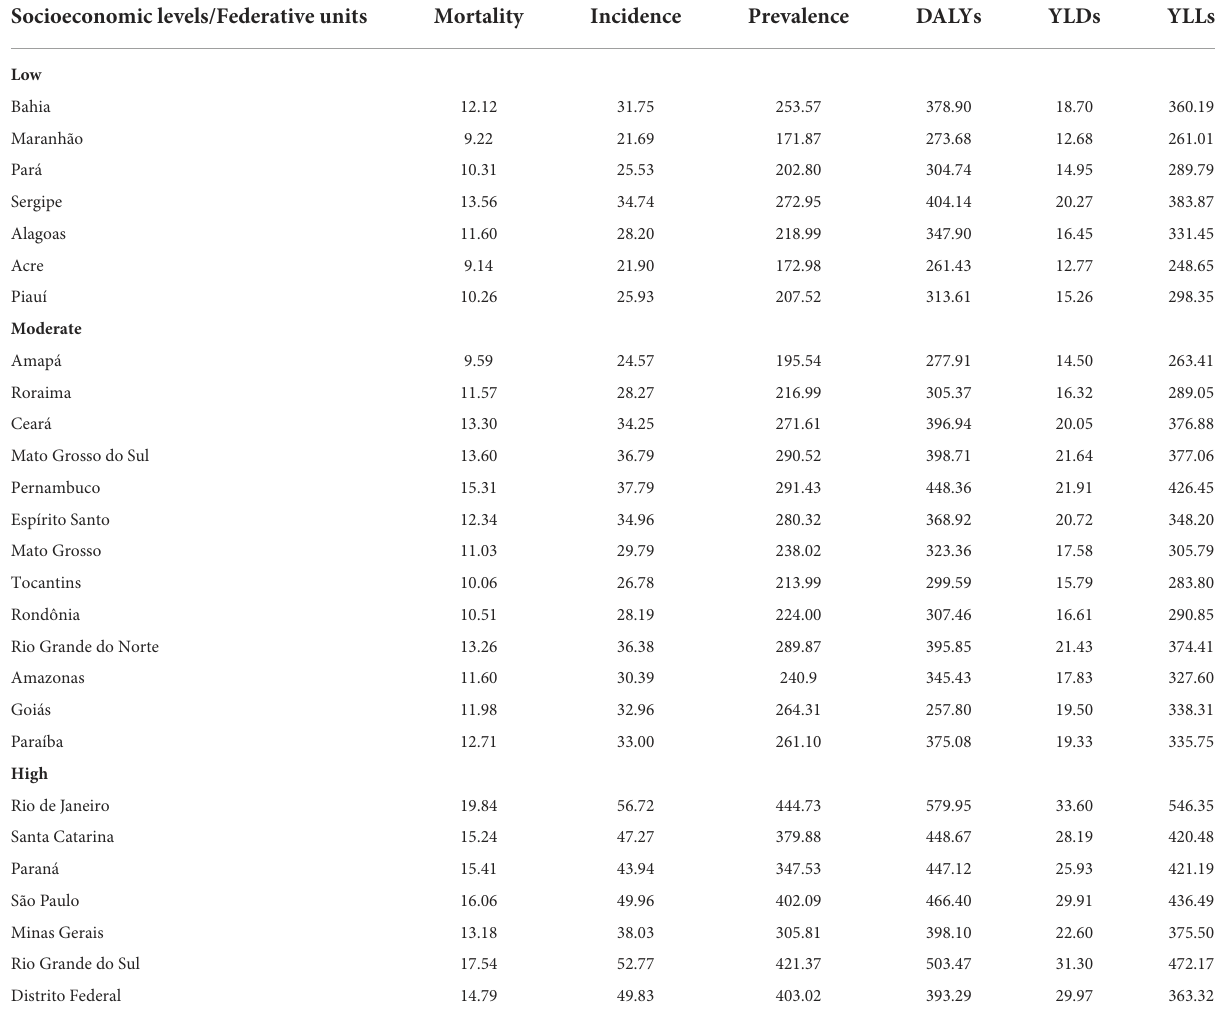
TABLE 1 Standardized rates of epidemiological indicators of female breast cancer (per 100 thousand inhabitants) in the federative units of Brazil, 2017. Socioeconomic levels/Federative units Mortality Incidence Prevalence DALYs YLDs